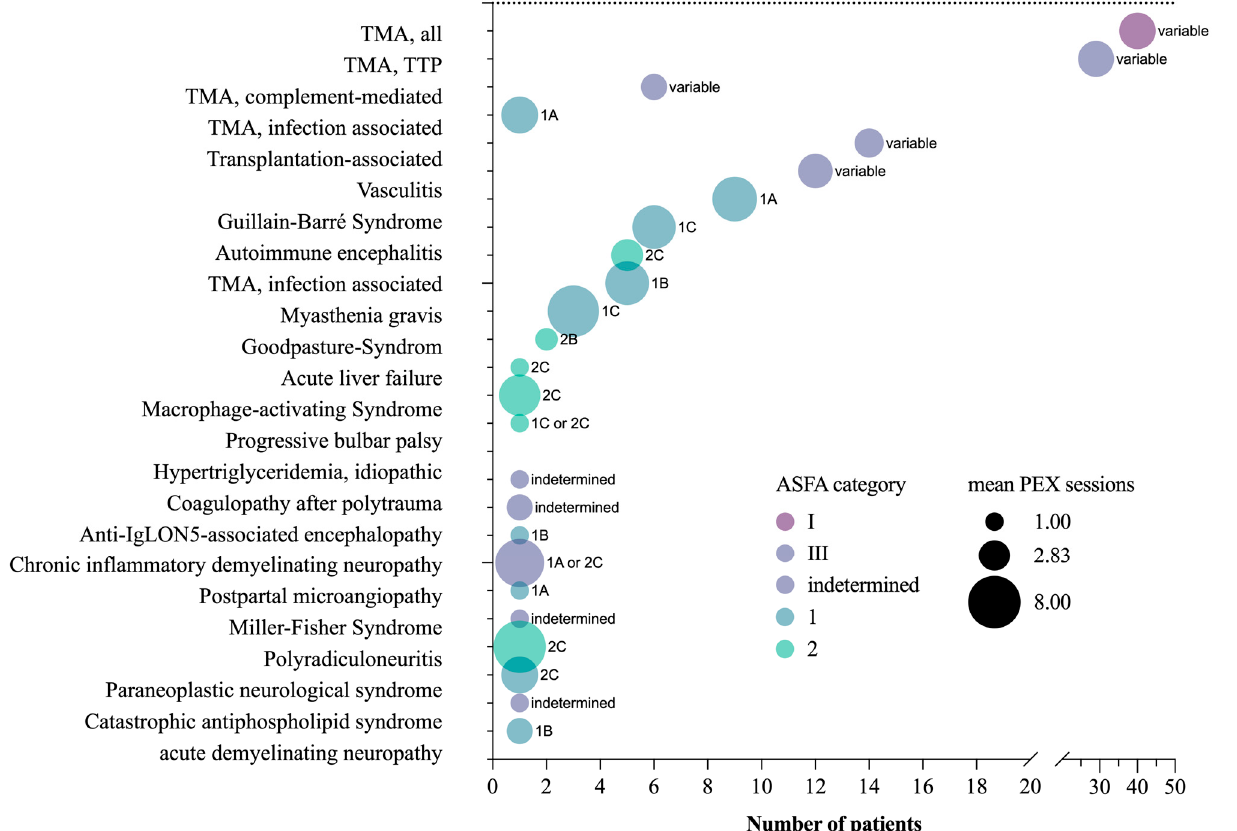
Figure 3. Combined analysis using indication for a number of patients, mean number of TPE sessions and ASFA category per TPE indication performed in an ICU se tt ing. Circle color—ASFA category, circle size—mean number of TPE sessions per indication, text right to circles—ASFA grade (full data set available in supplementary Table S1). Abbreviations: ASFA—American Society for